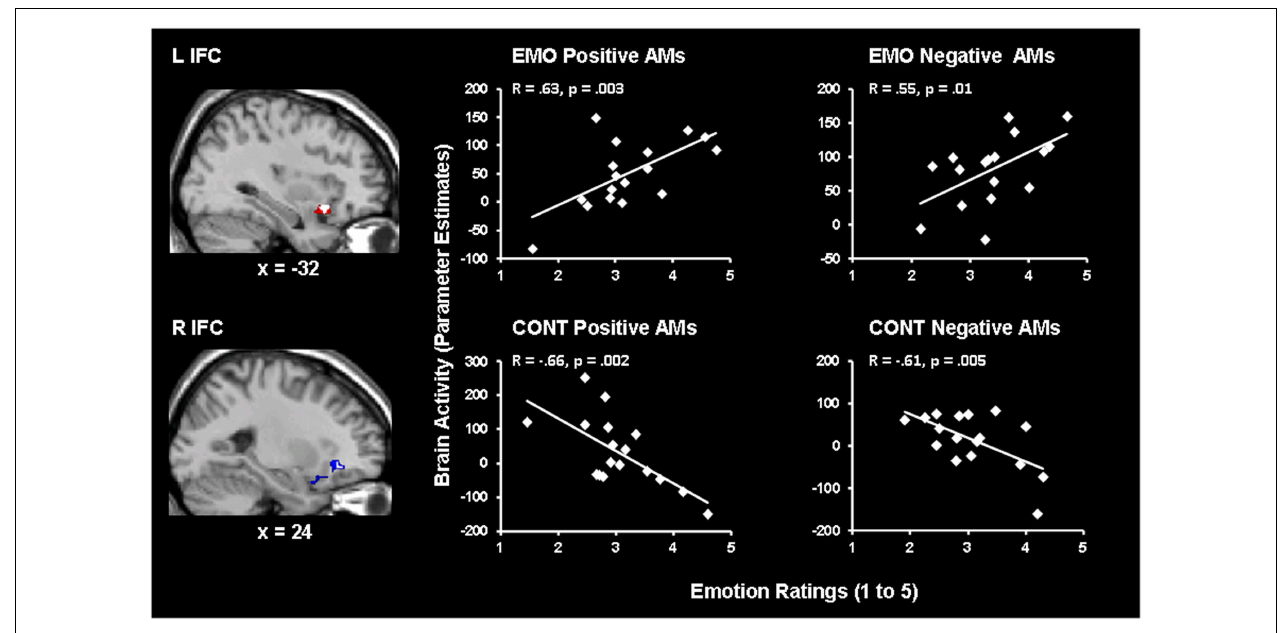
Talairach coordinates for the left/right hemispheres of the brain).The white blobs represent the areas where there are overlapping voxels for both positive and negative AMs, which are superimposed on larger areas showing positive (red) or negative (blue) co-variations either for positive or for negative AMs.The scatterplots are based on contrast estimates of the IFC activity for each condition, as extracted from the peak voxels of the areas showing the co-variation with the corresponding emotional ratings. L, Left; R, Right.